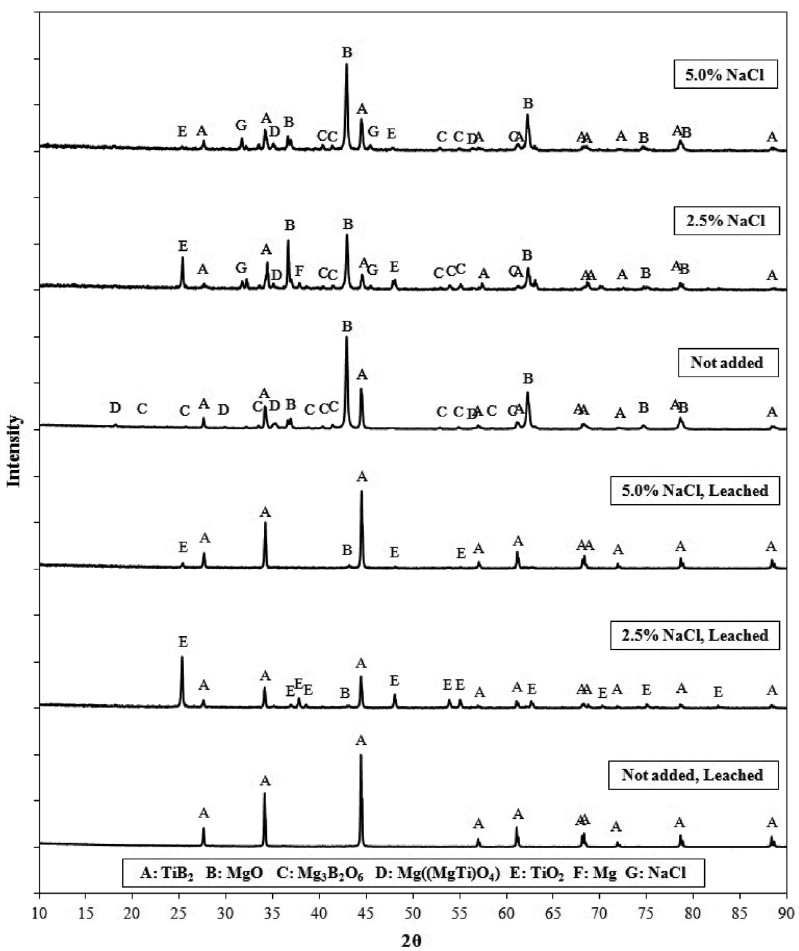
Fig. 4: XRD patterns of unleached and leached SHS products synthesized under argon atmosphere and stoichiometrically 100% Mg addition with increasing NaCl addition